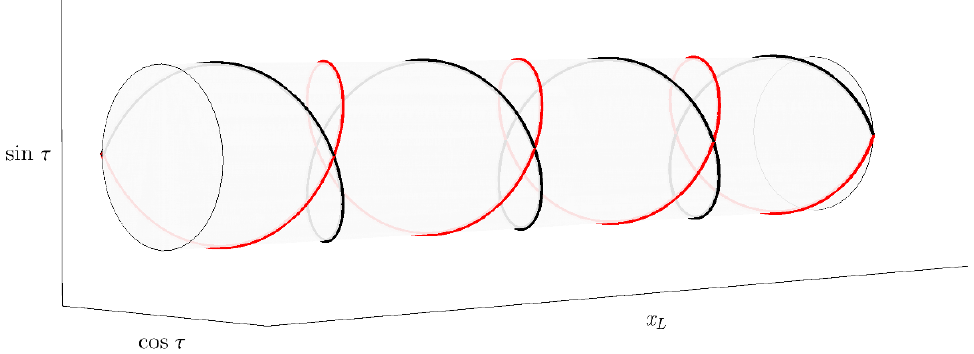
Figure 2. Lightlike trajectories moving in the x L direction and around the thermal circle. One trajectory is z = 0 and the other is (cid:22) z = 0. Poles in the Lorentzian inversion formula come from the neighborhood of these